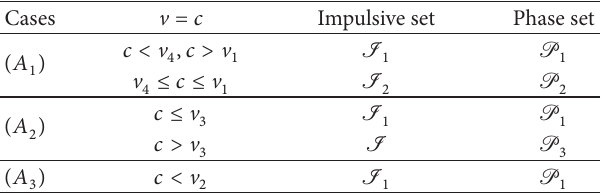
Table 1: Exact domains of impulsive set and phase set of system